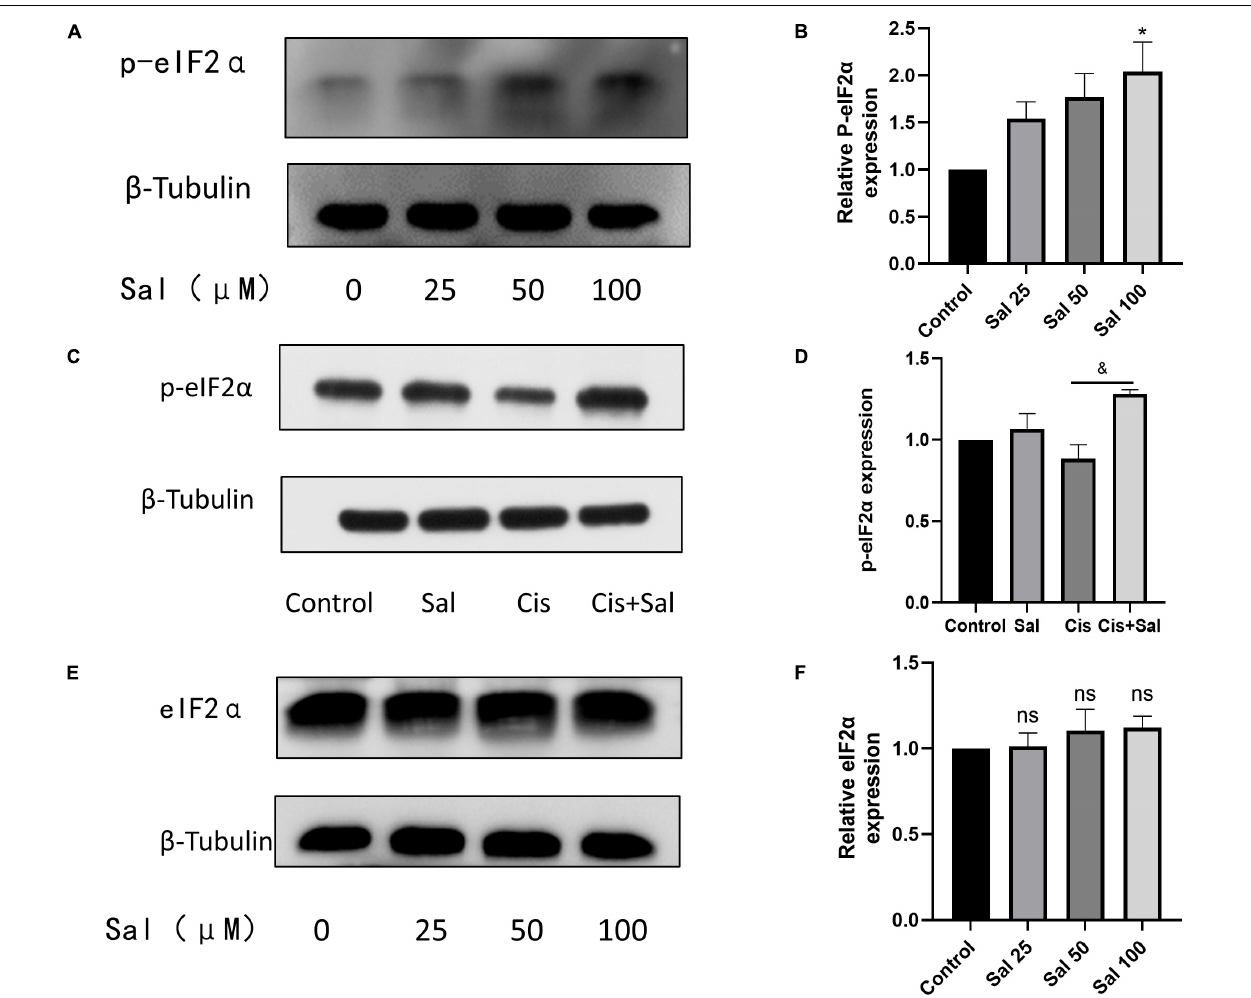
FIGURE 6 | Sal inhibits cisplatin-induced hair cell endoplasmic reticulum stress by inhibiting the dephosphorylation of p-eIF2 α . (A) As the concentration of Sal increases, p-eIF2 α expression increases. (B) Quantitative analysis of the data shown in (A) . (C) Sal increases p-eIF2 α expression in hair cell injury after cisplatin exposure. (D) Quantitative analysis of the data shown in (C) . (E) Western blotting results showing the expression of eIF2 α after Sal treatment. (F) Quantitative analysis of the data shown in (E) . Values are presented as mean ± SEM from independent experiments. * P < 0.05 vs. the control group; & P < 0.05 vs. the cisplatin group; ns, no statistical